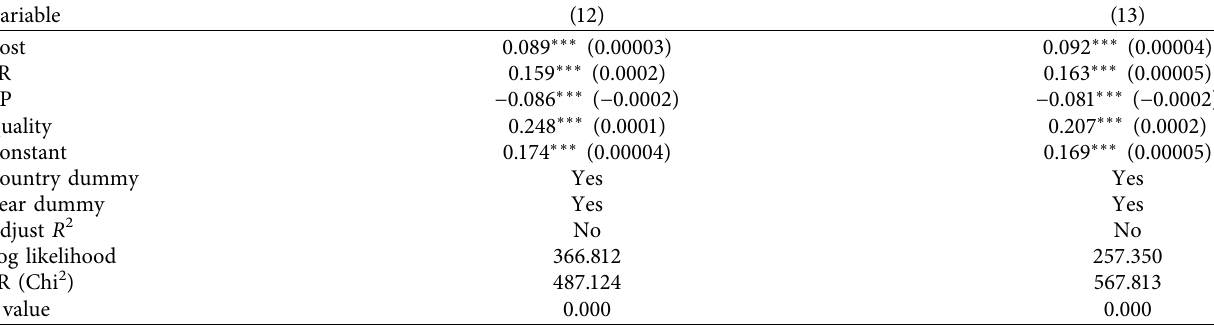
Table 5: Results of bargaining power using different quality equations.